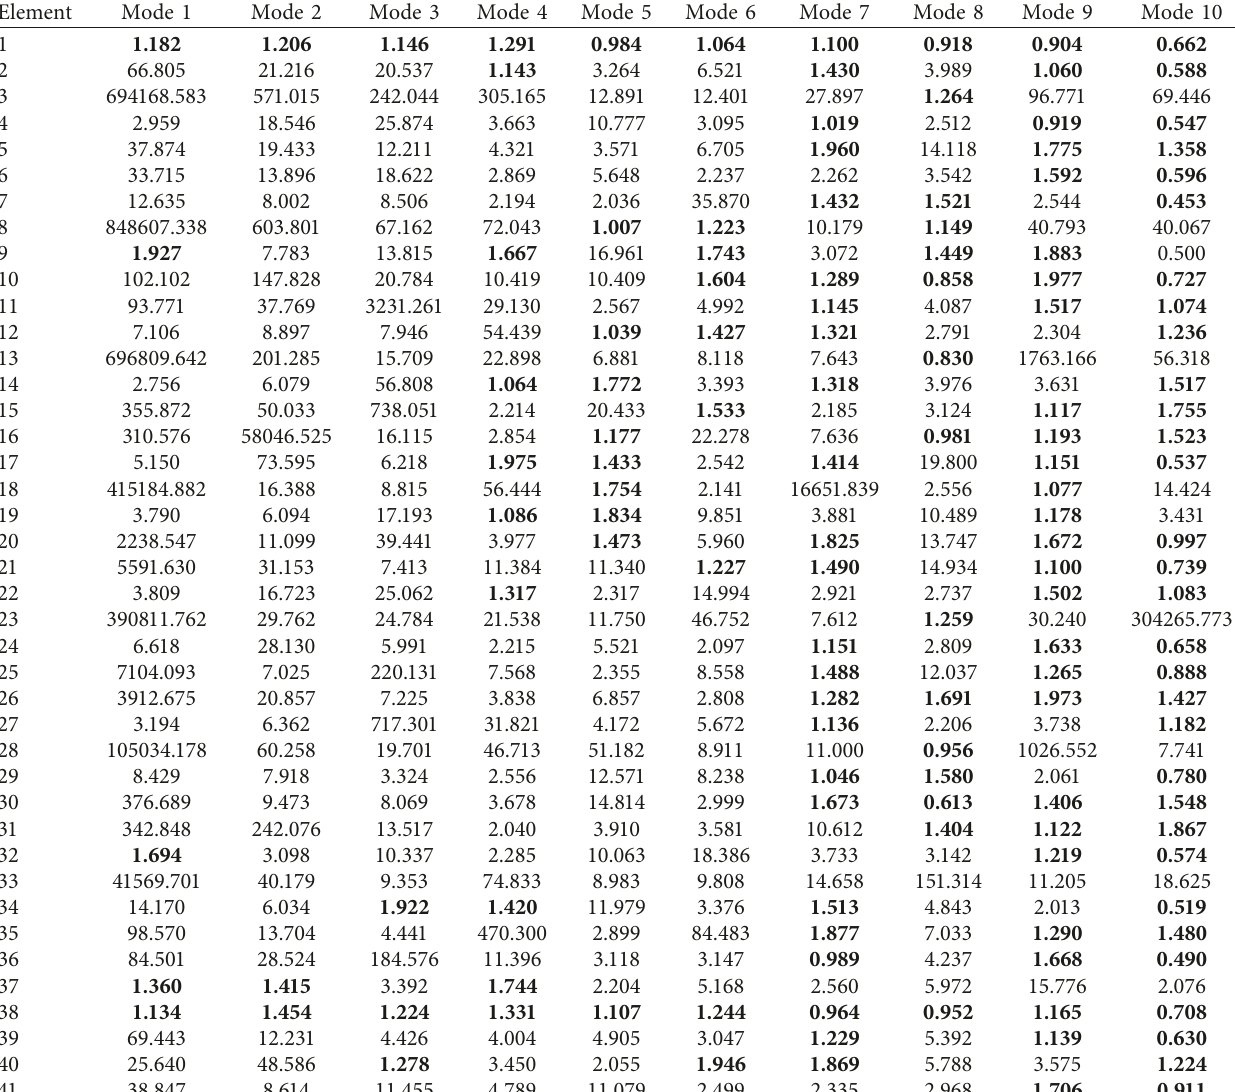
Table 3: RFA of all elements for the first ten modes based on 5000 samples.